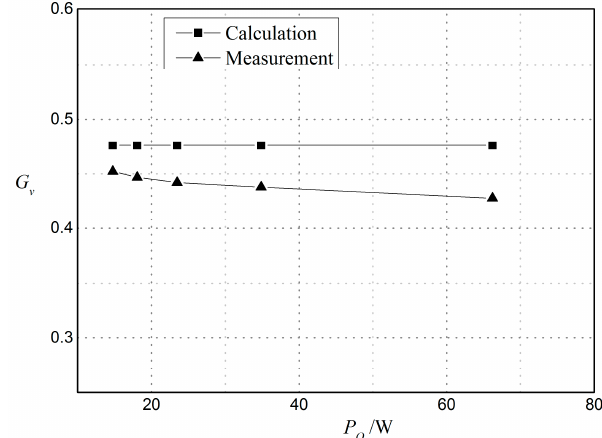
Figure 22. Comparison of theoretical value and experimental data of v G .